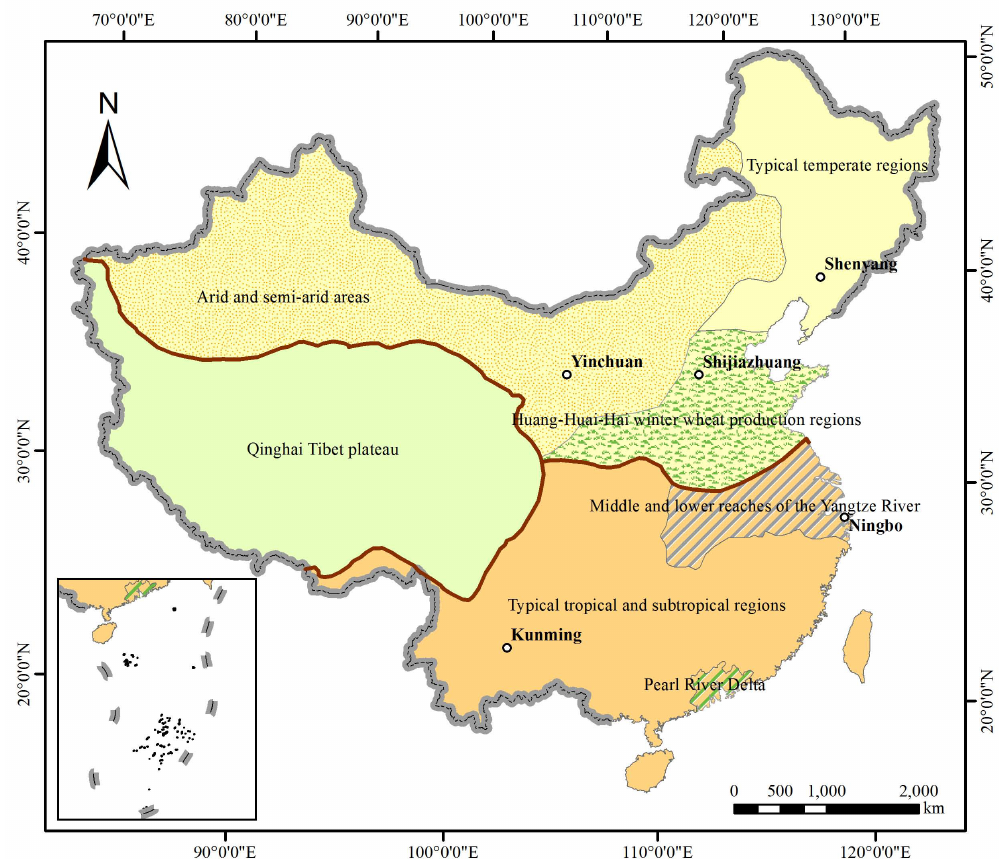
Figure 3. Ecological regionalization of impervious surfaces for remote